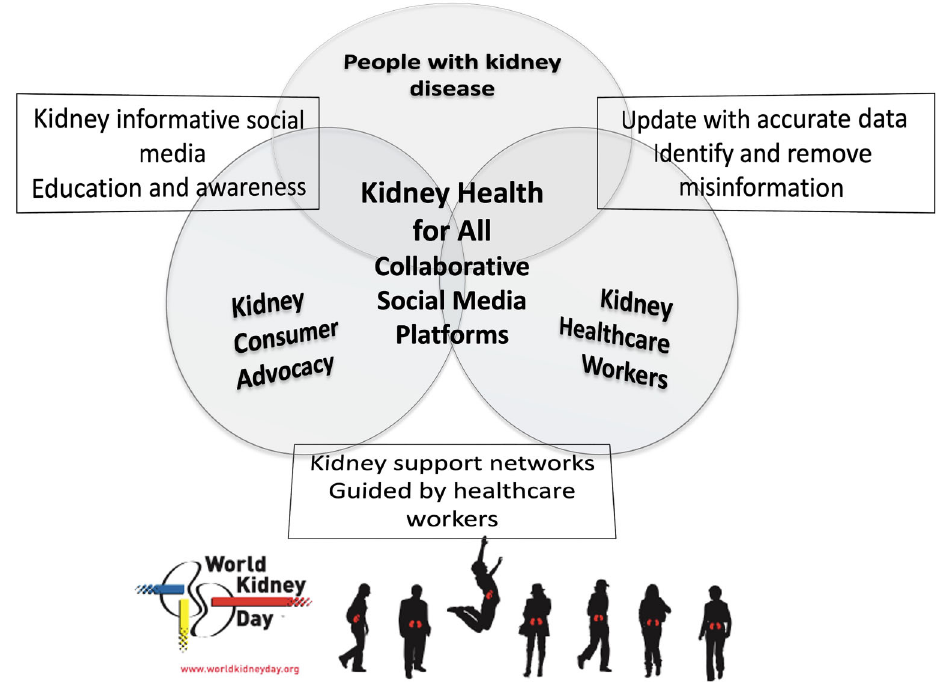
Figure 1. Schematic representation of consumer and health care professionals ’ collaborative advocacy using social media platforms with the goal of Kidney Health for All .